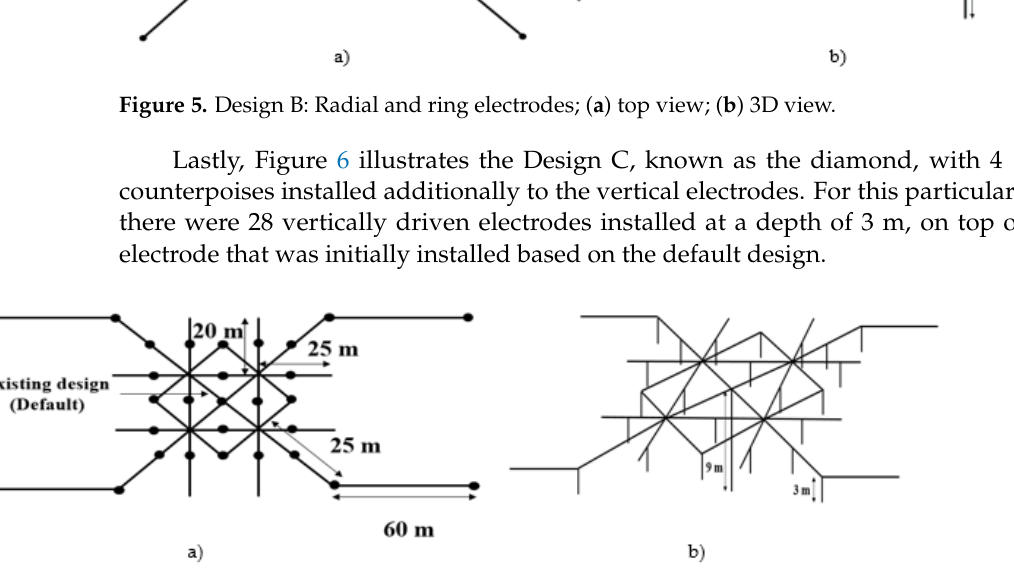
Figure 6. Design C: Diamond-style with counterpoise and vertical electrodes; ( a ) top view; ( b ) 3D view.